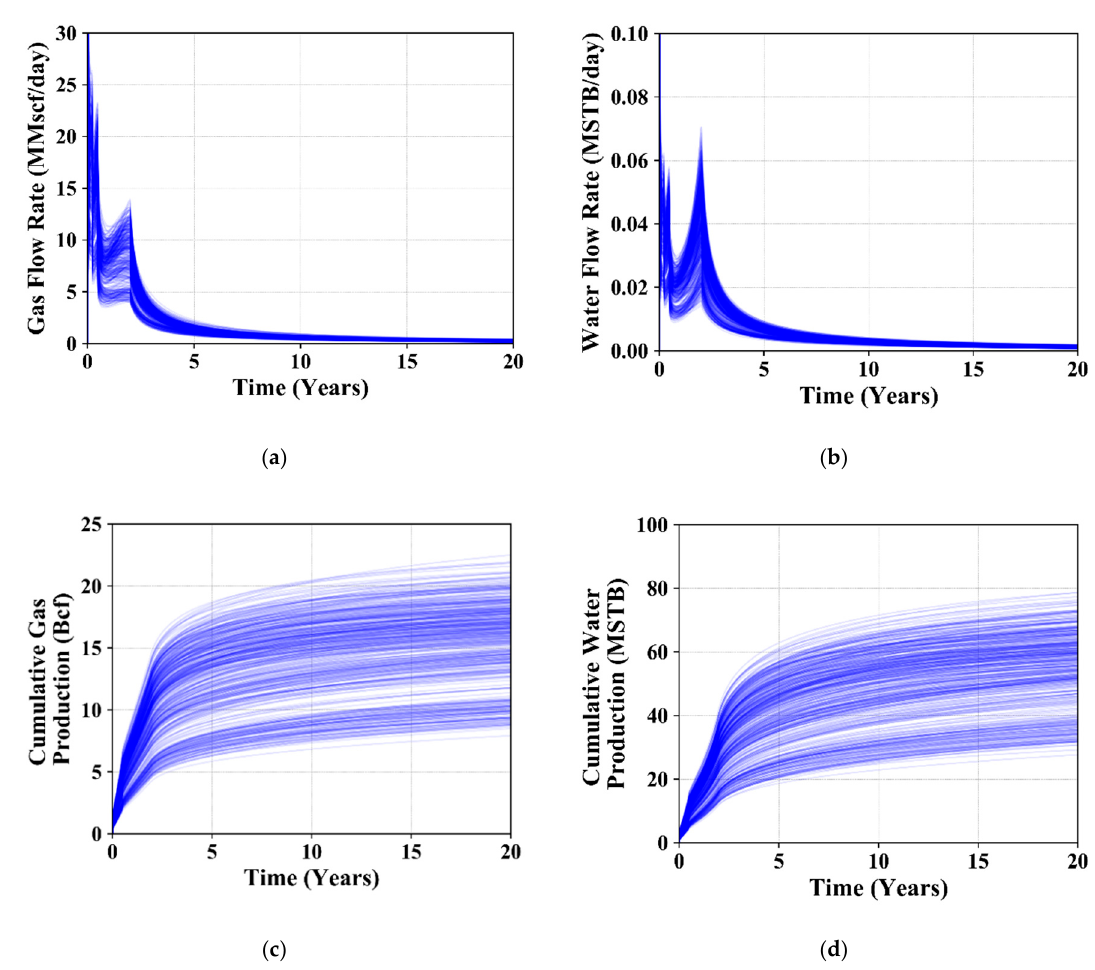
Figure 7. Gas and water flow rates and the cumulative gas and water production of all 500 simulation cases for the 5 different well spacing scenarios: ( a ) the gas flow rate; ( b ) the water flow rate; ( c ) the cumulative gas production; and ( d ) the cumulative water production.